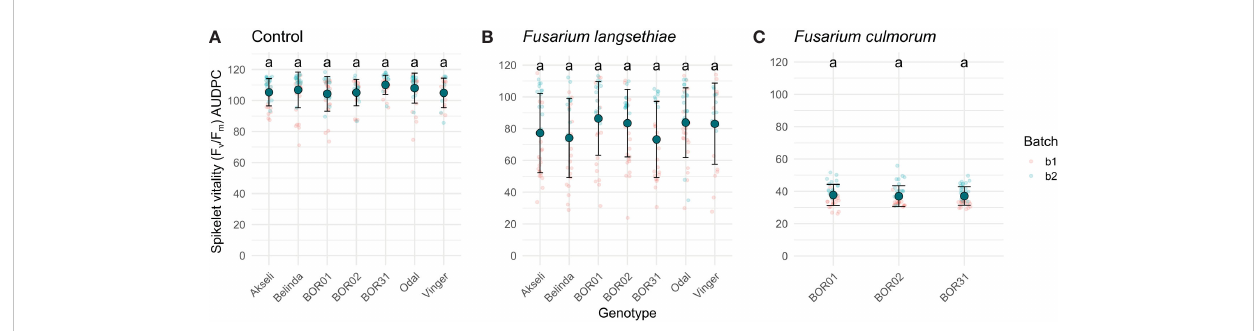
FIGURE 6 Area under the disease progression curve (AUDPC) of spikelet vitality measured by F v /F m . Plots show F v /F m AUDPC of the seven oat genotypes inoculated with (A) mock control, (B) F. langsethiae , or (C) F. culmorum . Small red dots correspond to data from batch 1 (b1) and small blue dots correspond to data from batch 2 (b2). Big teal dots represent AUDPC mean, and error bars represent standard deviation. Groups sharing the same letter have no statistical differences at p < 0.05 assessed by Tukey HSD post hoc test. This analysis includes combined data from two experimental batches. Each data point represents the mean of 21 – 38